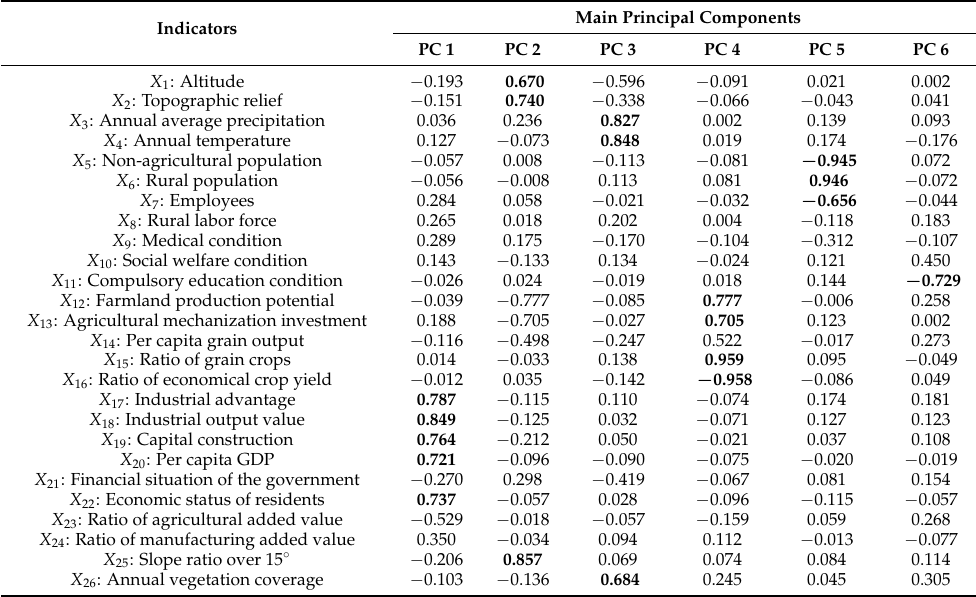
Table A1. The factor load of input indicators calculated by PCA. Indicators with numbers in bold are high loading factors for each PC.